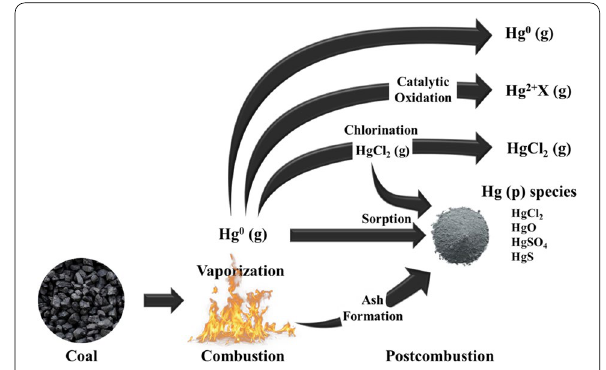
Fig. 3 Potential mercury transformations during coal combustion and in the resulting flue gas [16]